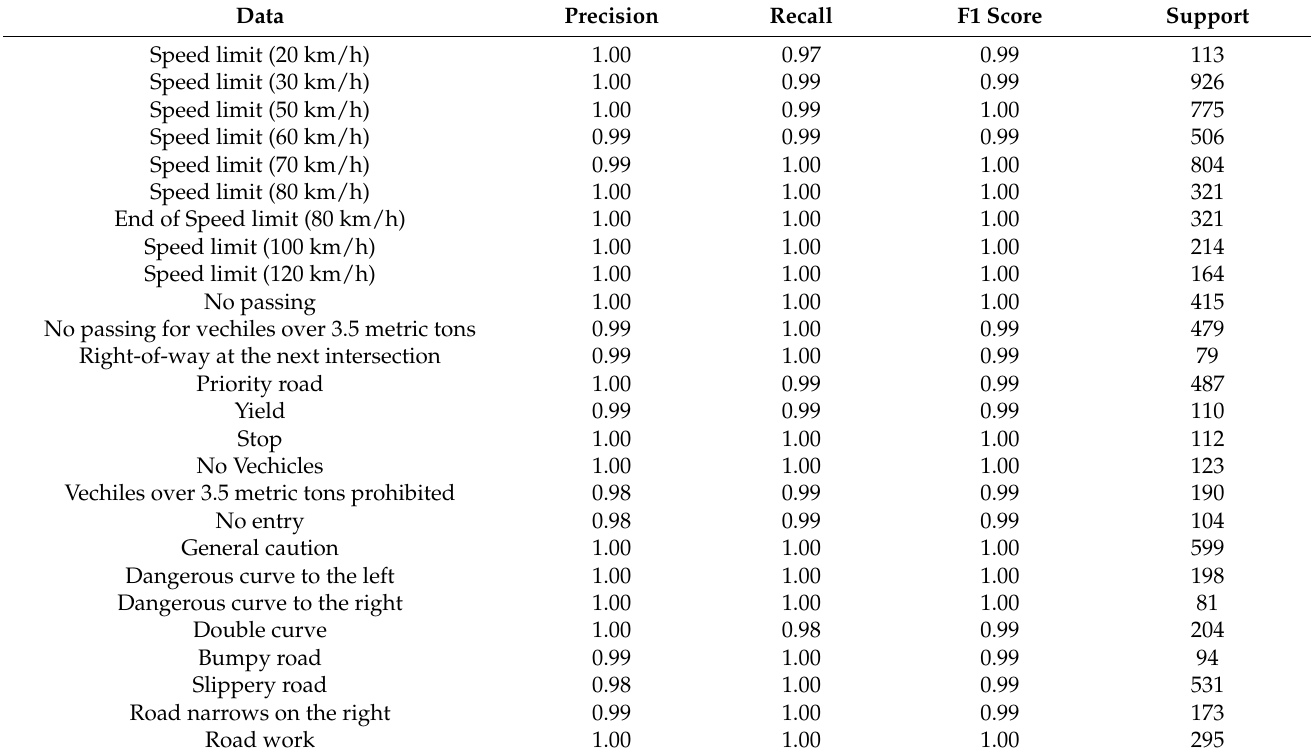
Table 4. Performance metrics score with different sets of